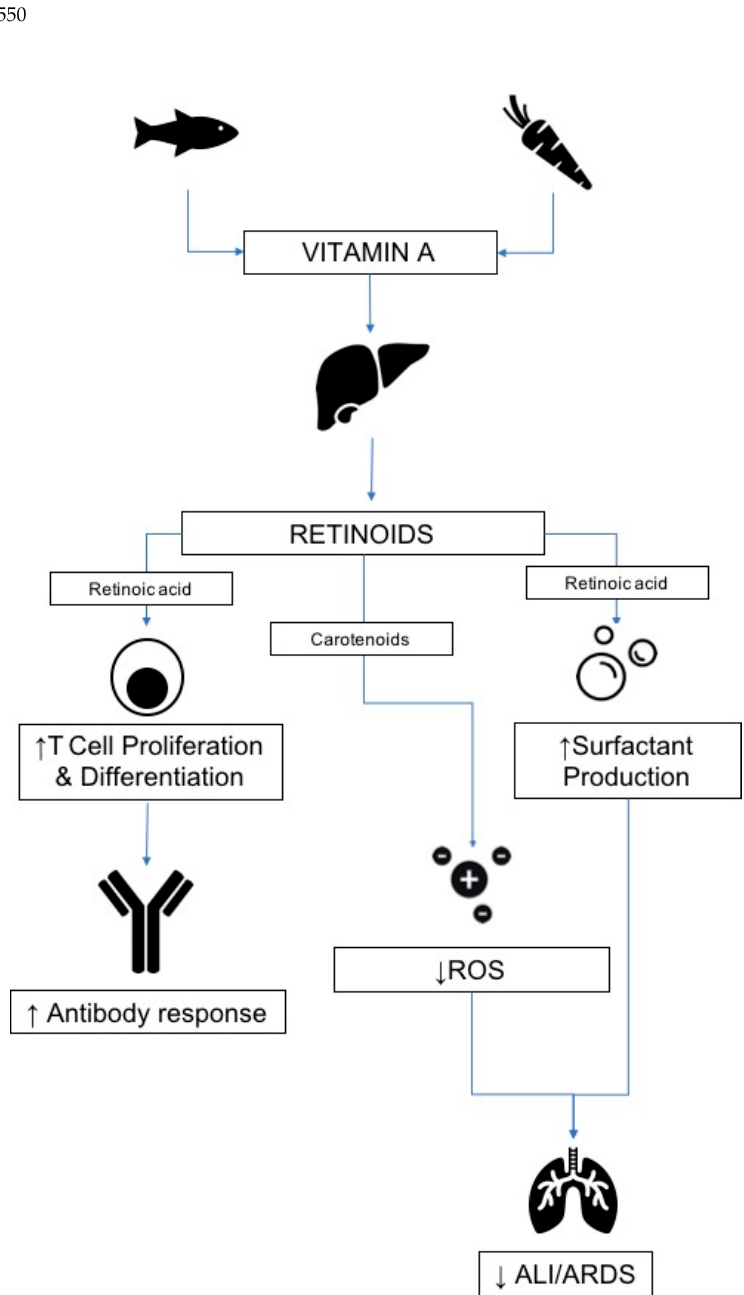
Figure 4. Retinoic acid and carotenoids exert a number of physiological effects, including the augmentation of T cell function, which may improve the adaptive immune response to pathogens, such as viruses. Furthermore, antioxidant and surfactant-mediating properties of vitamin A derivatives may have a protective role in the pathogenesis of ARDS, a known complication of severe cases of COVID-19.